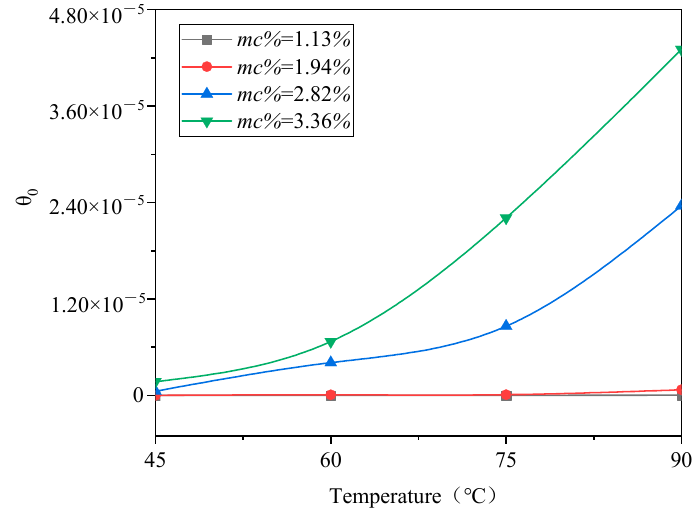
Figure 4. Coefficient θ 0 of cellulose pressboard with various moisture contents. Figure 4. Coe ffi cient θ 0 of cellulose pressboard with various moisture